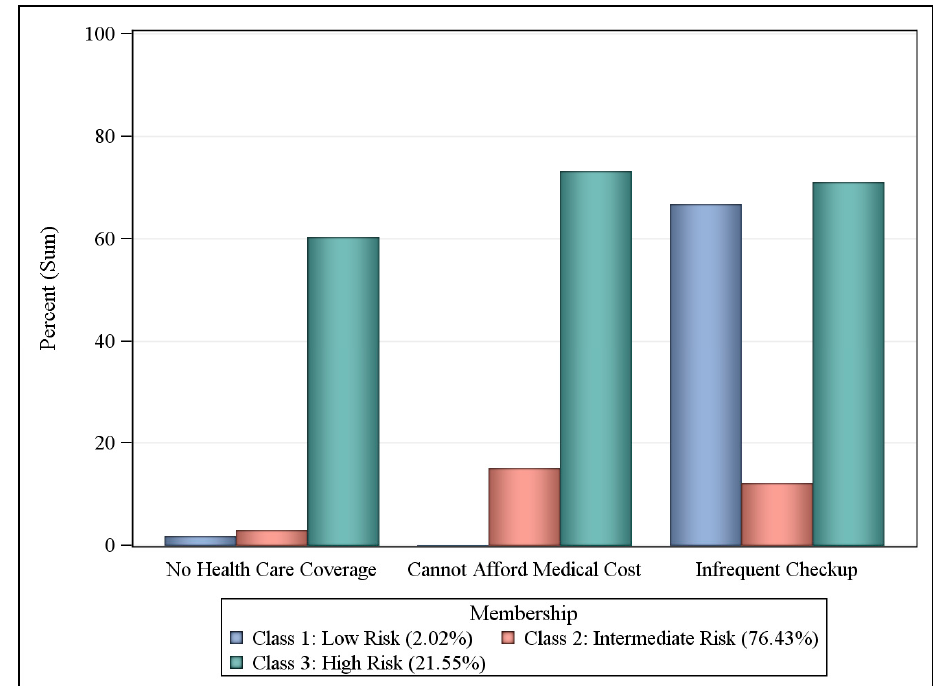
Figure 4. Probabilities of health care access by latent class, workers with COPD in KY, TN, NC, and WV BRFSS respondents, 2016 and 2017. Table 2. Odds ratios (ORs) of frequent physical distress, mental distress, and activity limitation by individual and healthcare system risk domains, employed adults reporting diagnosis of COPD in KY, NC, WV, and TN, BRFSS, 2016–2017 1